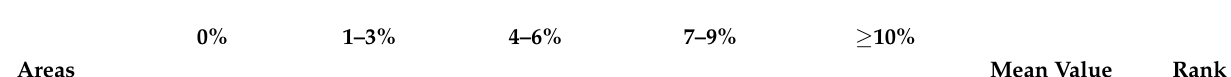
Table 7. Respondents’ perception of project performance